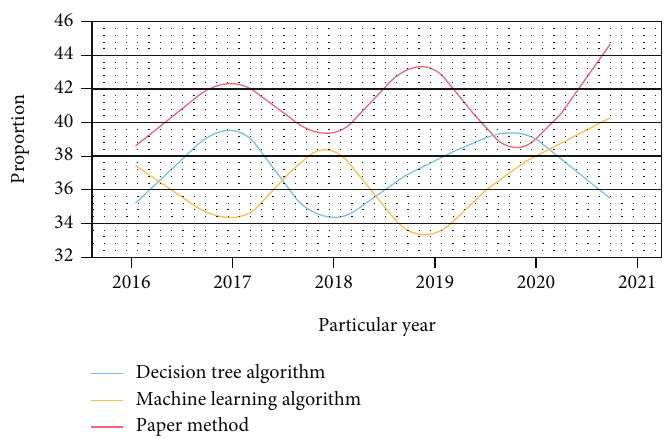
Figure 5: Number of times of live operation in distribution network of power grid factory.